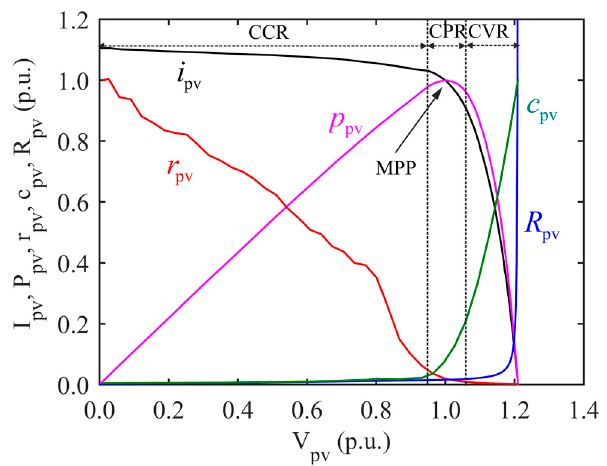
Figure 3. The characteristic per-unit curves of Raloss SR-30-36 PV panel at the irradiation of 500 W/m 2 .